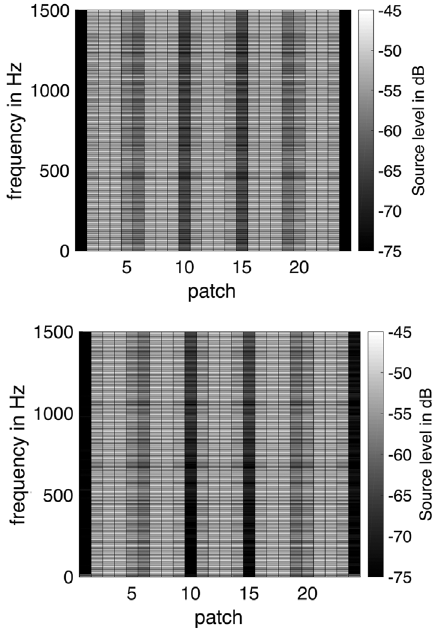
Figure 18. Comparison of the original source distribution along the 24 patches (upper) and the reconstructed source distribution (lower) as function of frequency for N p = 5. Reconstruction based on near- fi eld receiving